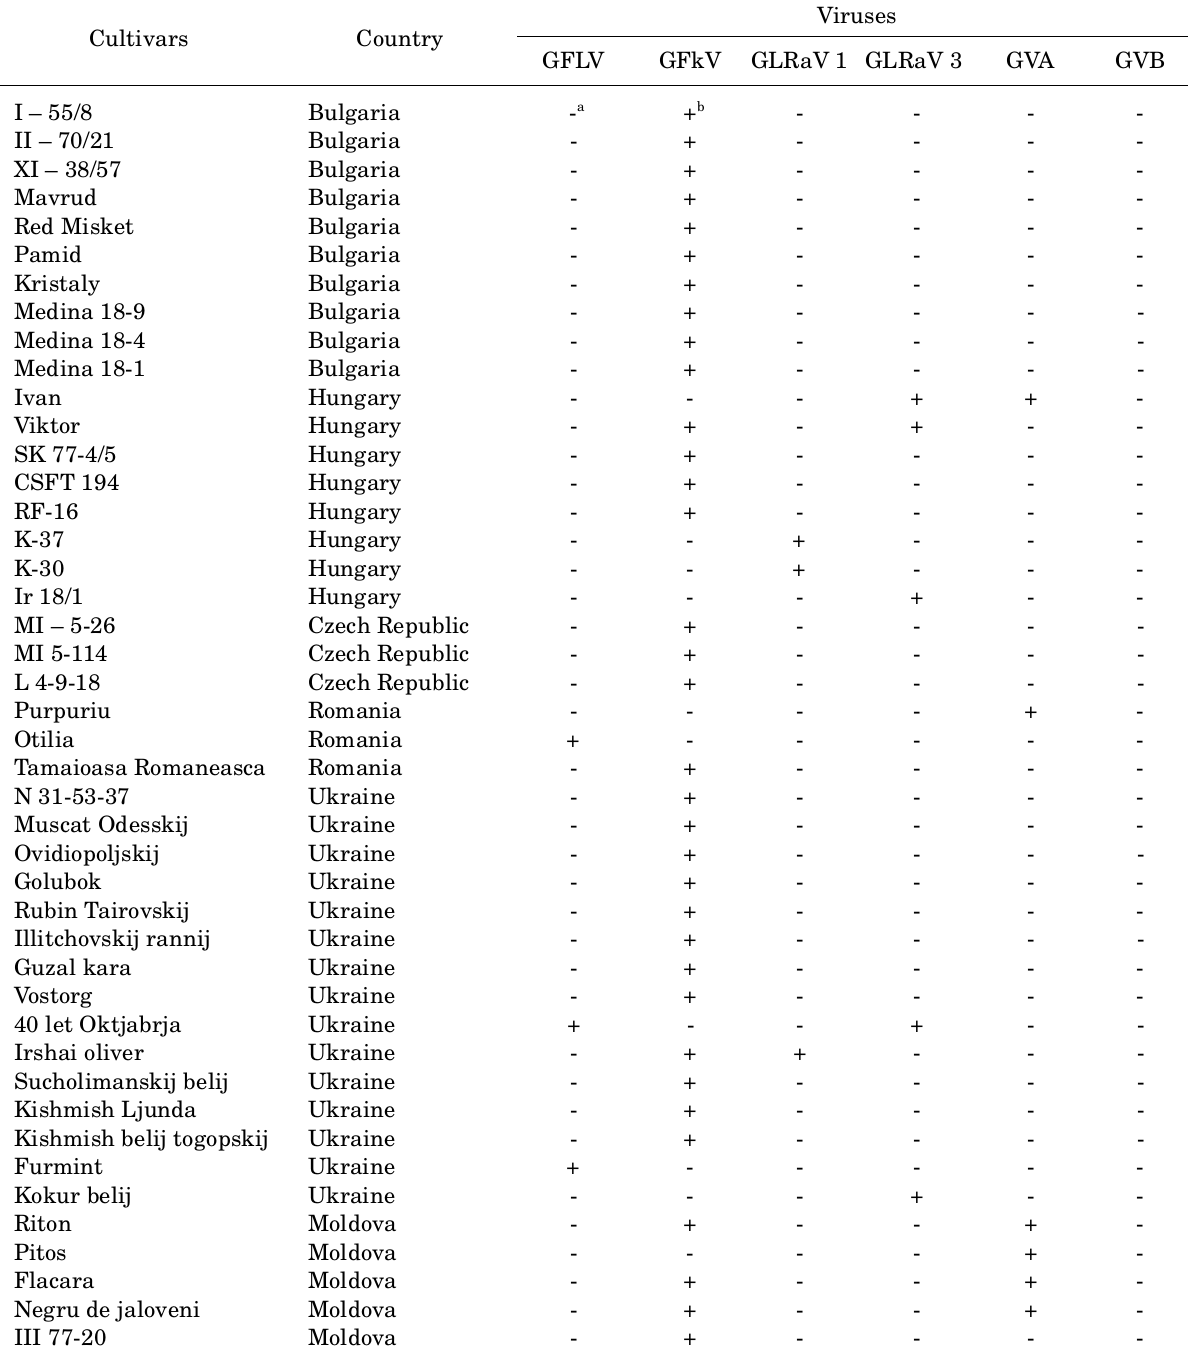
Table 1. Virus infected grape cultivars from eastern Europe